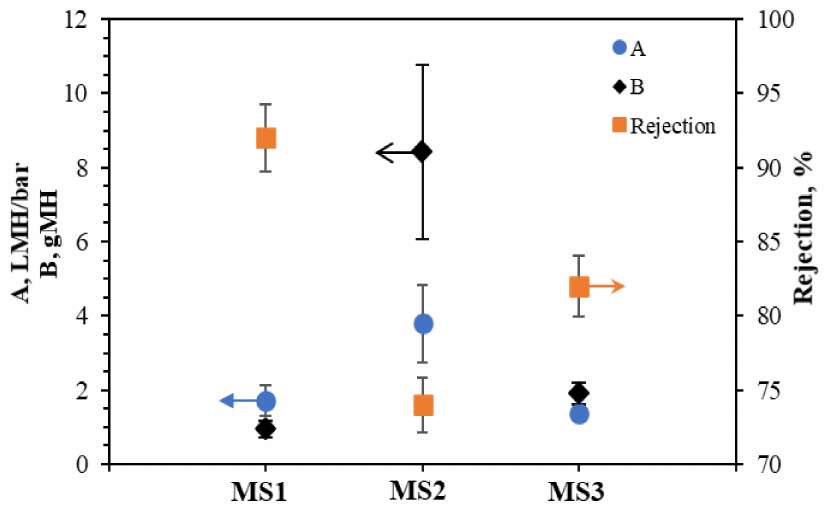
Figure 6. Water and salt permeability coefficients A and B and salt rejection ( R ) for the TFC FO